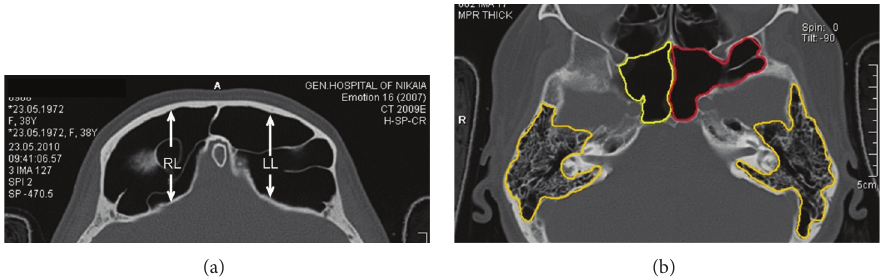
Figure 2: (a) Linear measurements of frontal sinus in the axial plane (RL: anteroposterior length of the right sinus and LL: anteroposterior length of the left sinus). (b) Area calculation of the sphenoid sinuses and the mastoid air cells in the axial plane.